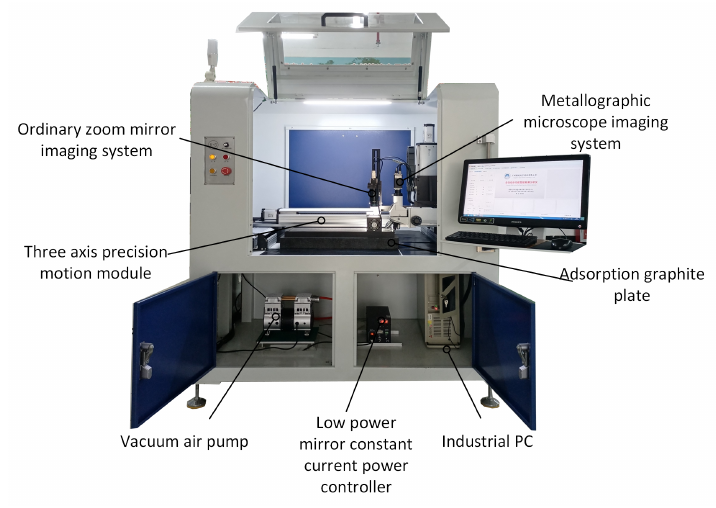
Figure 7. Physical image of the intelligent detector for the appearance defect of